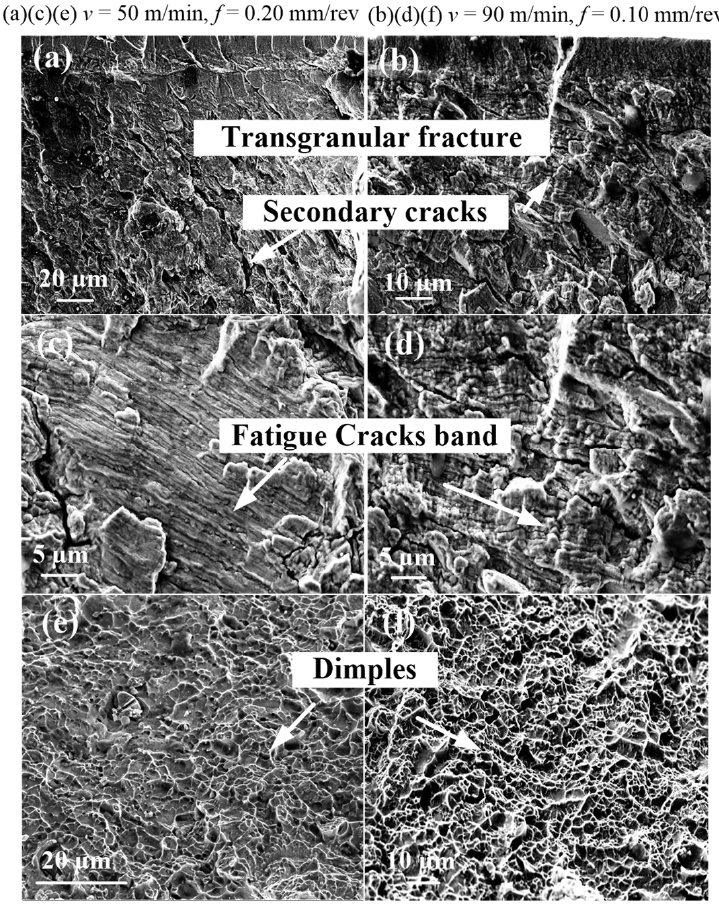
Figure 8. Low-cycle fatigue fracture morphology ( a , b ) source zone characteristics, ( c , d ) fatigue expansion zone characteristics, ( e , f ) transient fault zone characteristics. Note: ( a , c , e high tempera- ture v = 50 m/min, f = 0.20 mm/rev, a p = 0.20 mm; ( b , d , f ) high temperature v = 90 m/min, f = 0.10 mm/rev, a p = 0.20 mm).